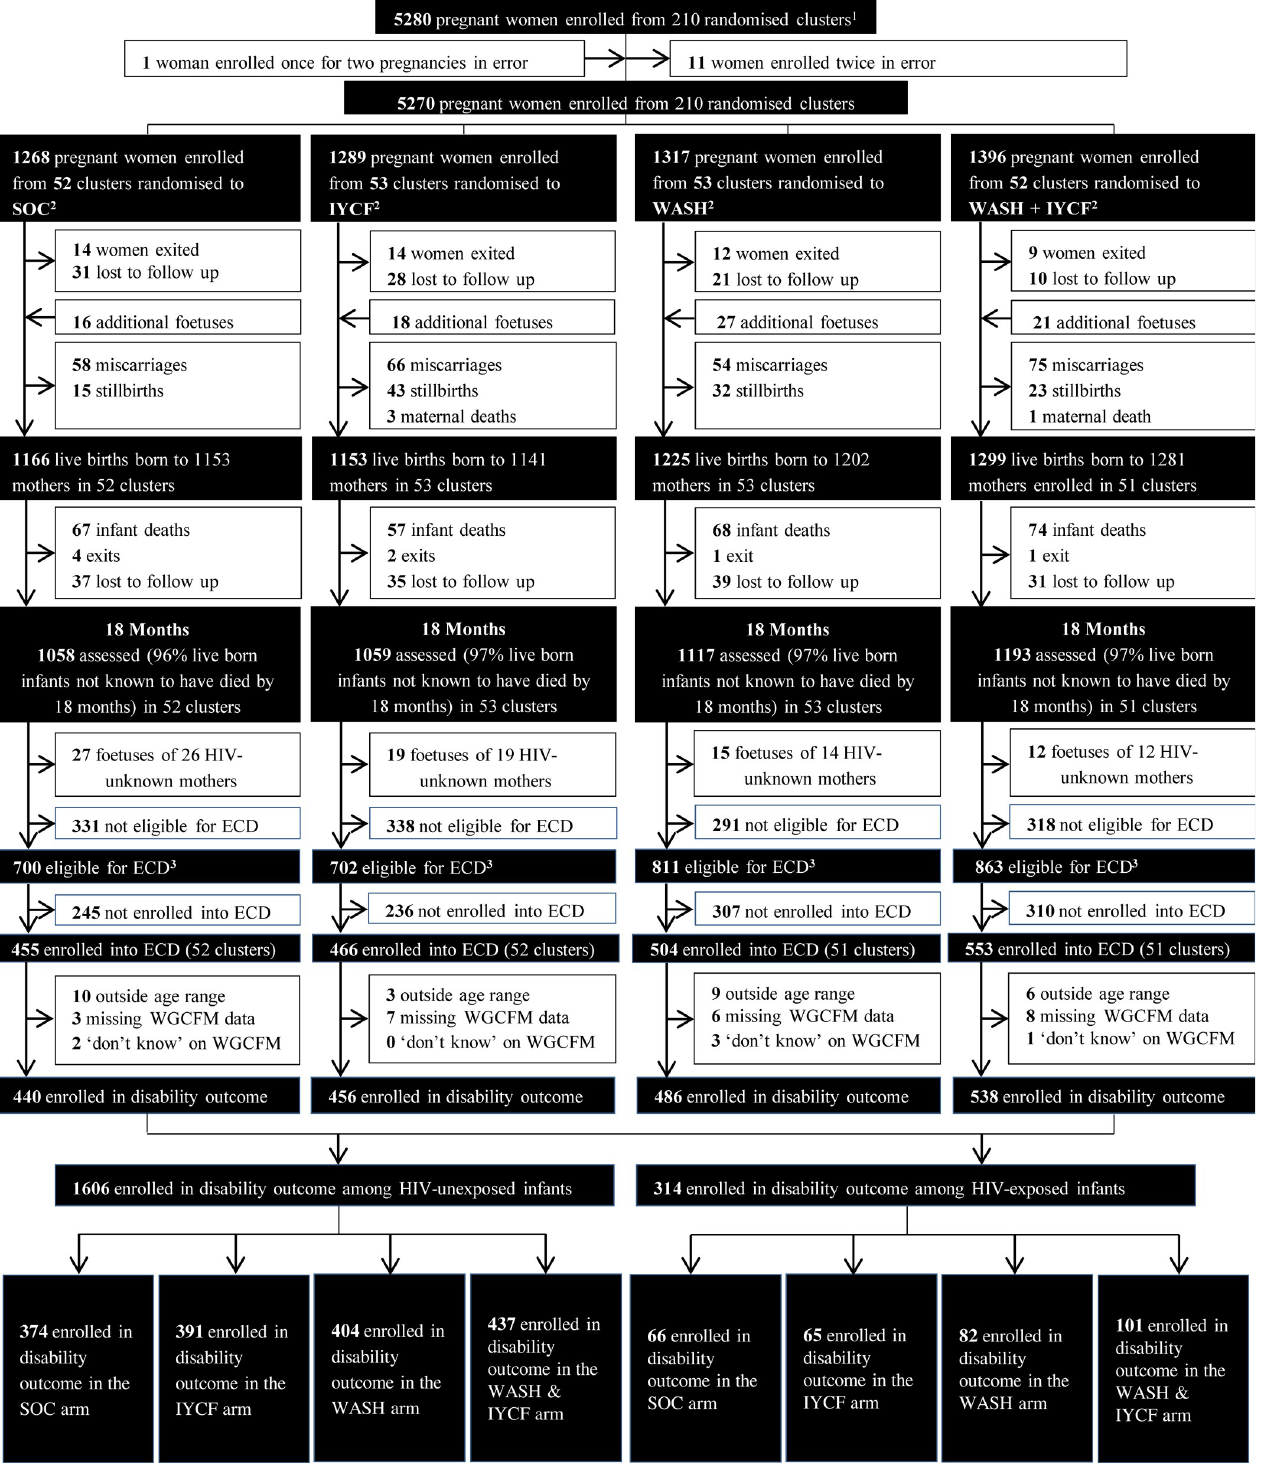
Fig 1. CONSORT flow diagram. 212 clusters were randomised, 53 in each of the four trial arms. After randomisation, one cluster was excluded as it was determined to be in an urban area, one cluster was excluded as the VHW covering it mainly had clients outside the study area, and one more was merged into a neighbouring cluster based on subsequent data on VHW coverage. Three new cluster designations were created due to anomalies in the original mapping; for two of these, the trial arm was clear—the third contained areas that were in two trial arms, and was assigned to the underrepresented arm, resulting in 53